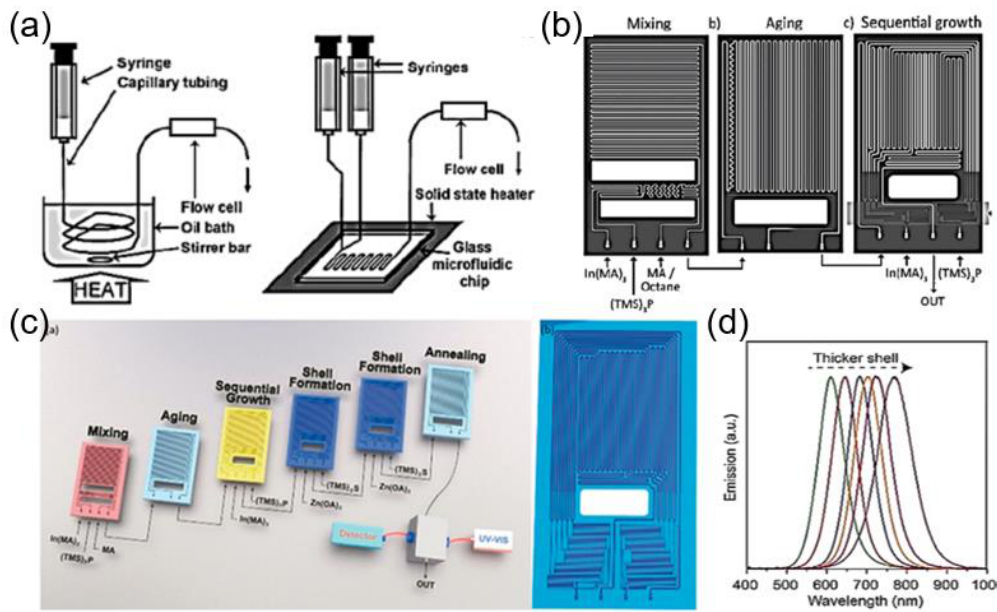
Figure 9. ( a ) Schematic illustration of single-capillary and Y-shaped microfluidic devices for the synthesis of InP QDs (reproduced from [63], with permission from the Wiley-VCH Verlag GmbH & Co, 2009). ( b ) Schematic illustration of the microfluidic reactor having three functions, including mixing, aging, and sequential injection (reproduced from [64], with permission from the Wiley-VCH Verlag GmbH & Co, 2011). ( c ) Illustration of a multistage microfluidic platform for the synthesis of core-shell InP / ZnS QDs. ( d ) Emission spectra of the InP / CdS QDs (reproduced from [67], with permission from the Wiley-VCH Verlag GmbH & Co, 2018).